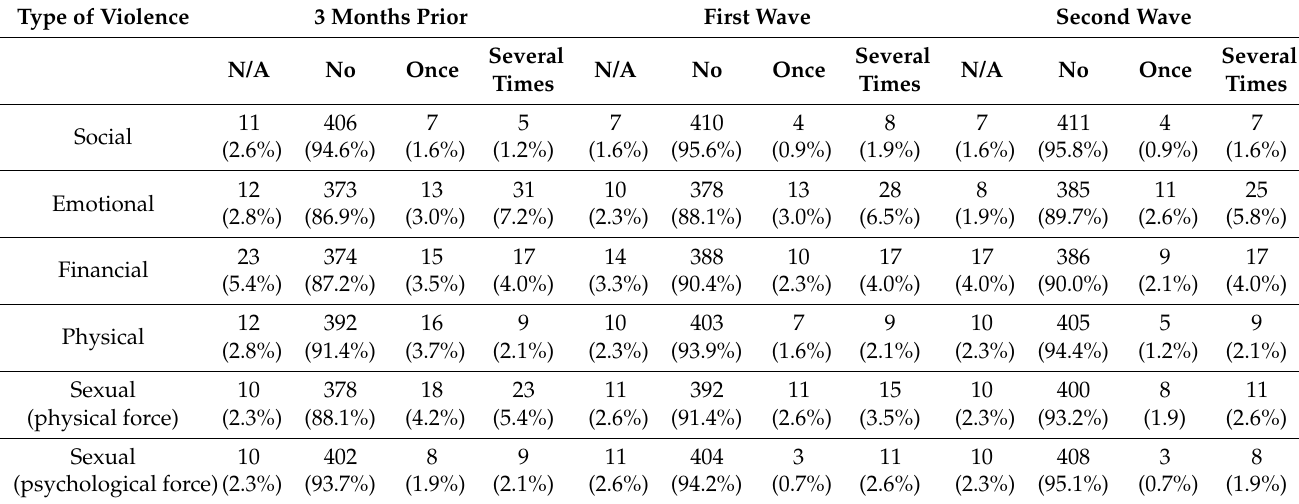
Table A1. Overview of the incidence of individual types of IPV in three time